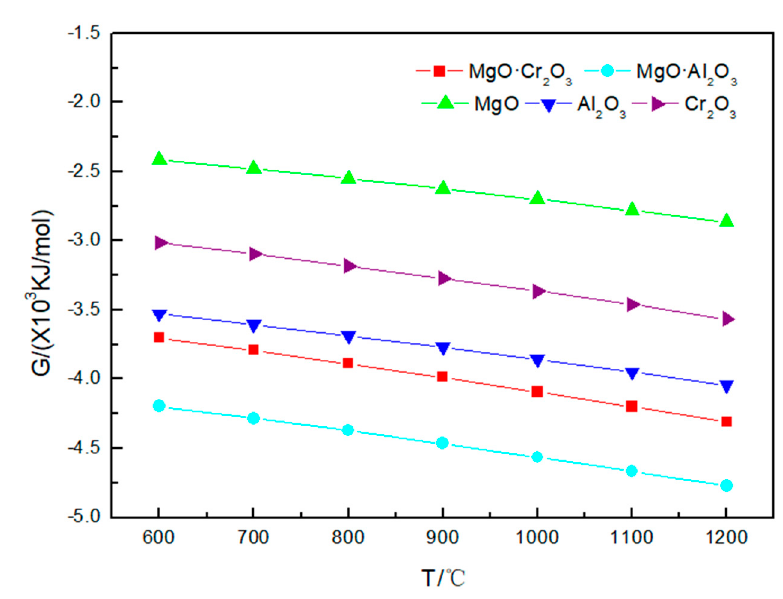
Figure 3. Gibbs free energy of the five corrosion reactions between Na 2 SO 4 and refractory materials at 600–1200 °C. Table 2. Predicted corrosion products and reaction equations of Na 2 SO 4 on refractory materials